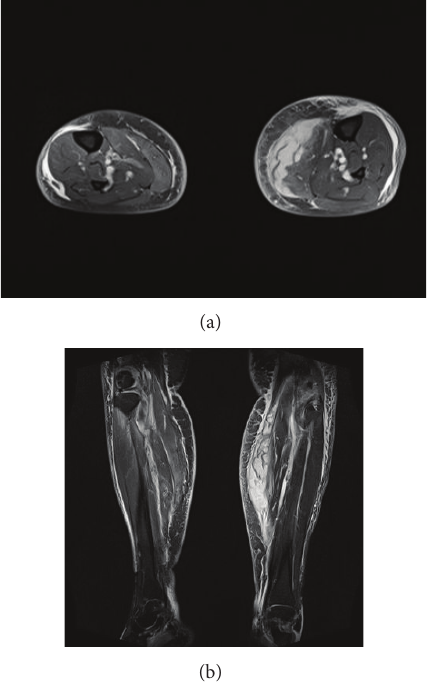
Figure 3: Postoperative T1-weighted MR images of both crures, revealing fluid collection in the posterior